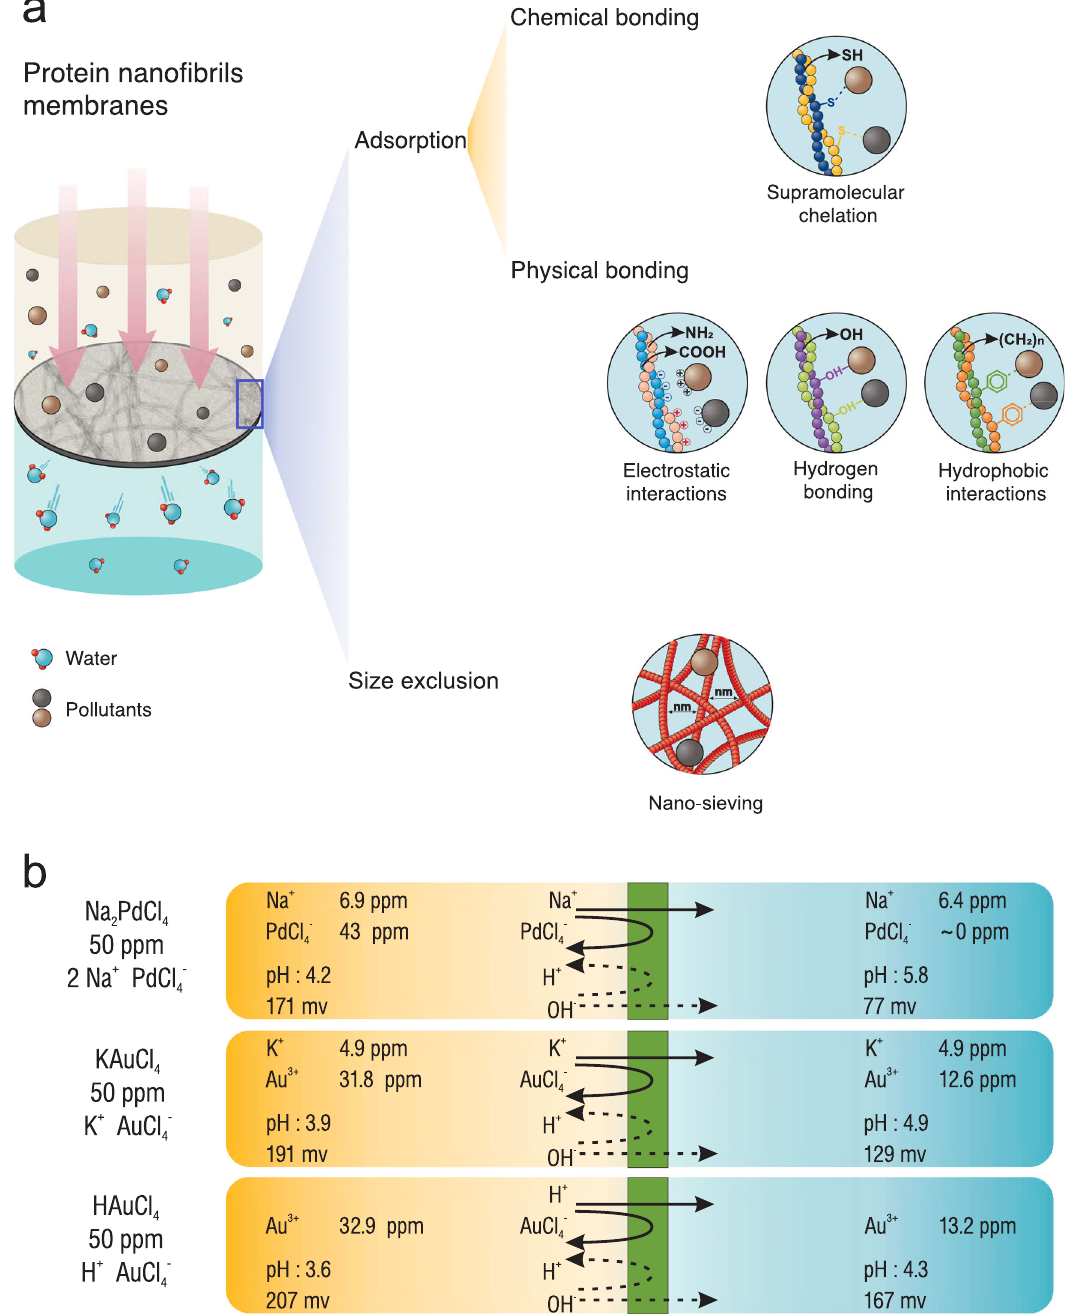
Fig. 2 Working principles for water puri fi cation by protein nano fi brils for. a Different mechanisms for pollutants removal by protein nano fi brils membranes. b Selectivity and main parameters during the water fi ltration by protein nano fi brils